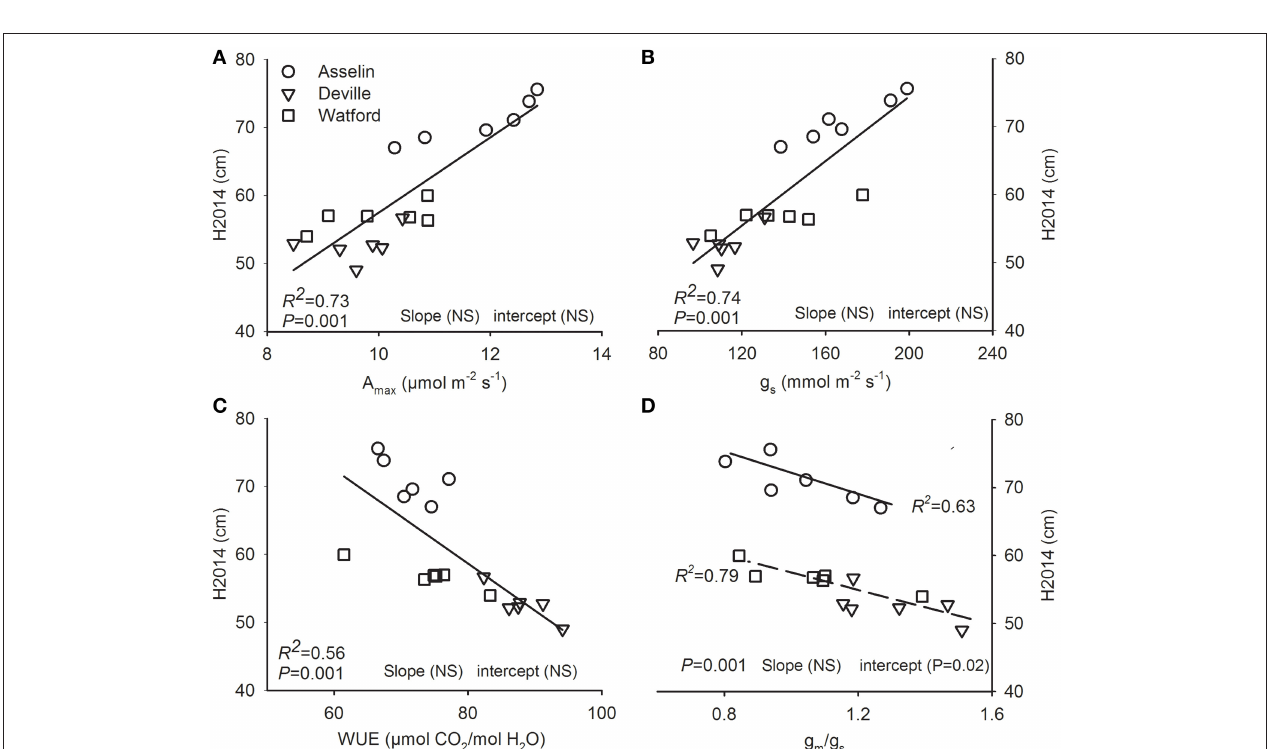
previous findings (Kogami et al., 2001; Dang et al., 2008;